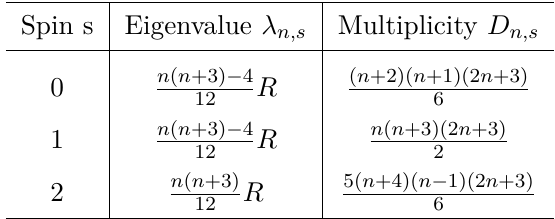
Table 1 . Multiplicities and eigenvalues for the four-sphere space-time traces. The sums for T 2 and T Jac begin at n φ = 2 , for T Jac 1